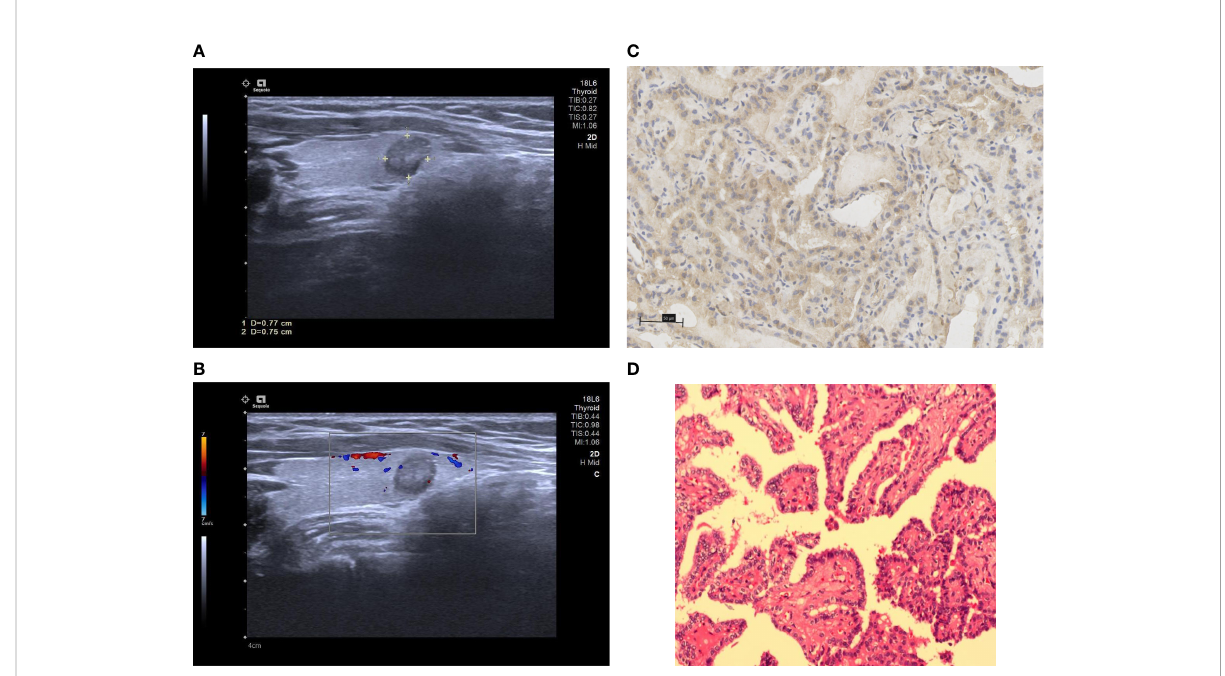
FIGURE 2 The above images were from a 28-year-old female patient. (A) a conventional two-dimensional image. The nodule was 7.7 mm x 7.5 mm in size and contained microcalci fi cations. (B) CDFI of the nodule, which only showed a few punctate blood fl ow signals. (C) the high expression of WNT10A. (D) pathological sections of the lesion indicating